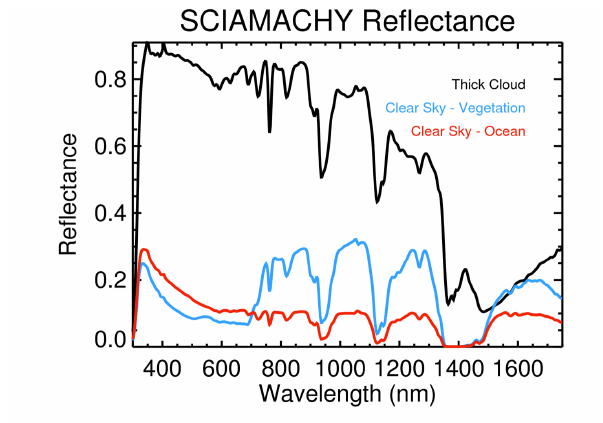
Fig. 1. SCIAMACHY-measured reflectance spectra for three scene types: a thick cloud (black), cloud-free vegetation (blue), and cloud- free ocean